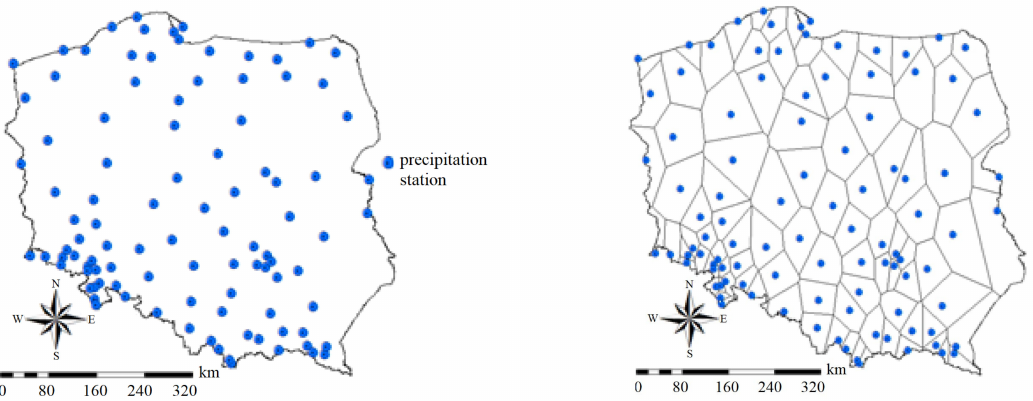
Figure 17. Thiessen Polygons based on precipitation measurement sites in